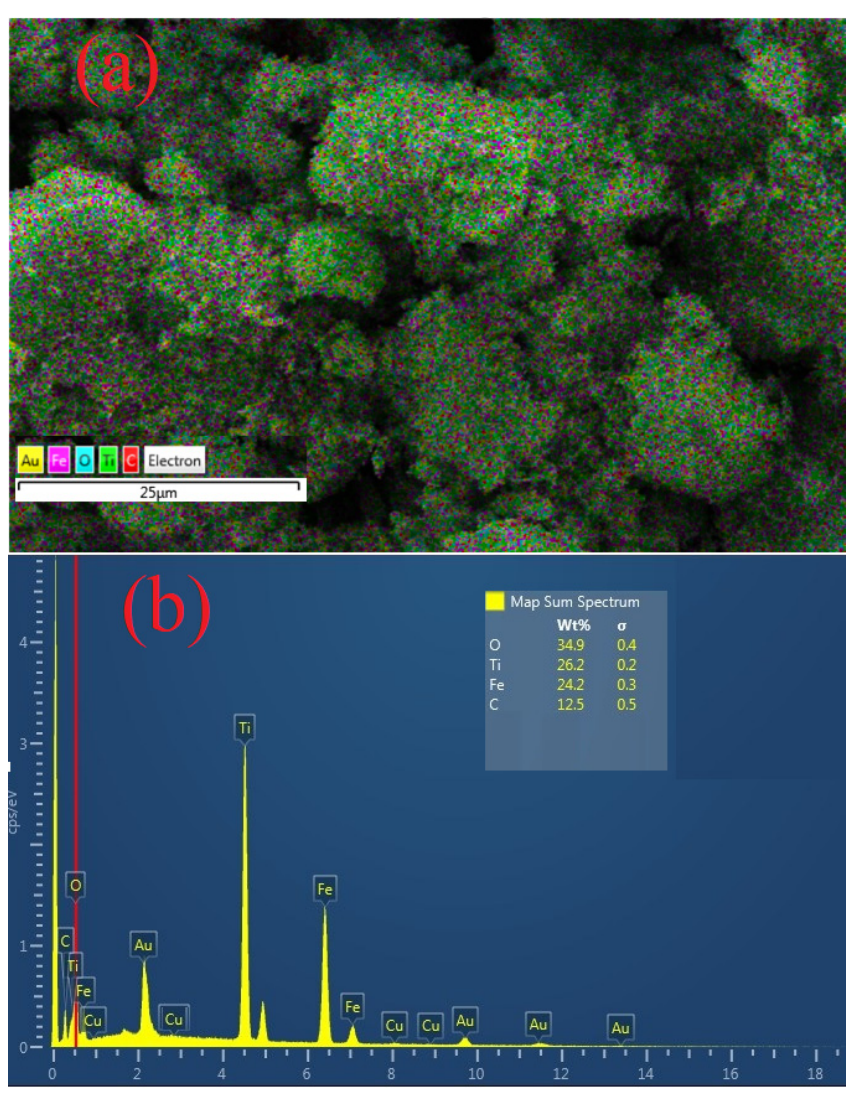
Figure 2. ( a ) Elemental mapping and ( b ) EDS spectrum of Fe 9 TiO 15 .TiO 2 .